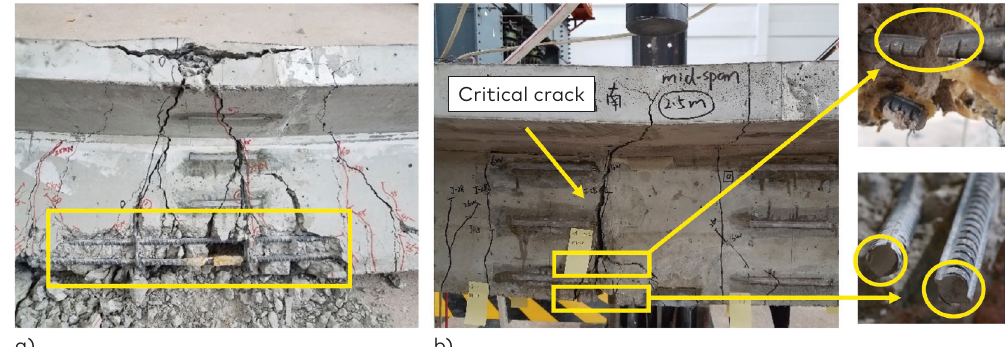
Figure 4. Typical failure modes of RC T-beams under a) static and b) fatigue